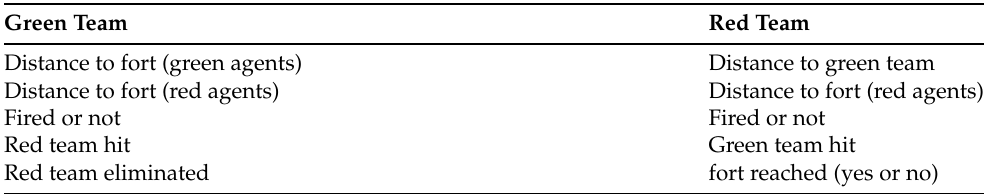
Table A3. Rewards of green and red